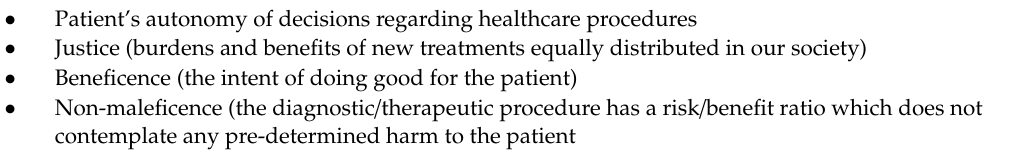
Table 6. Principles for an ethical medical practice (after Gillon